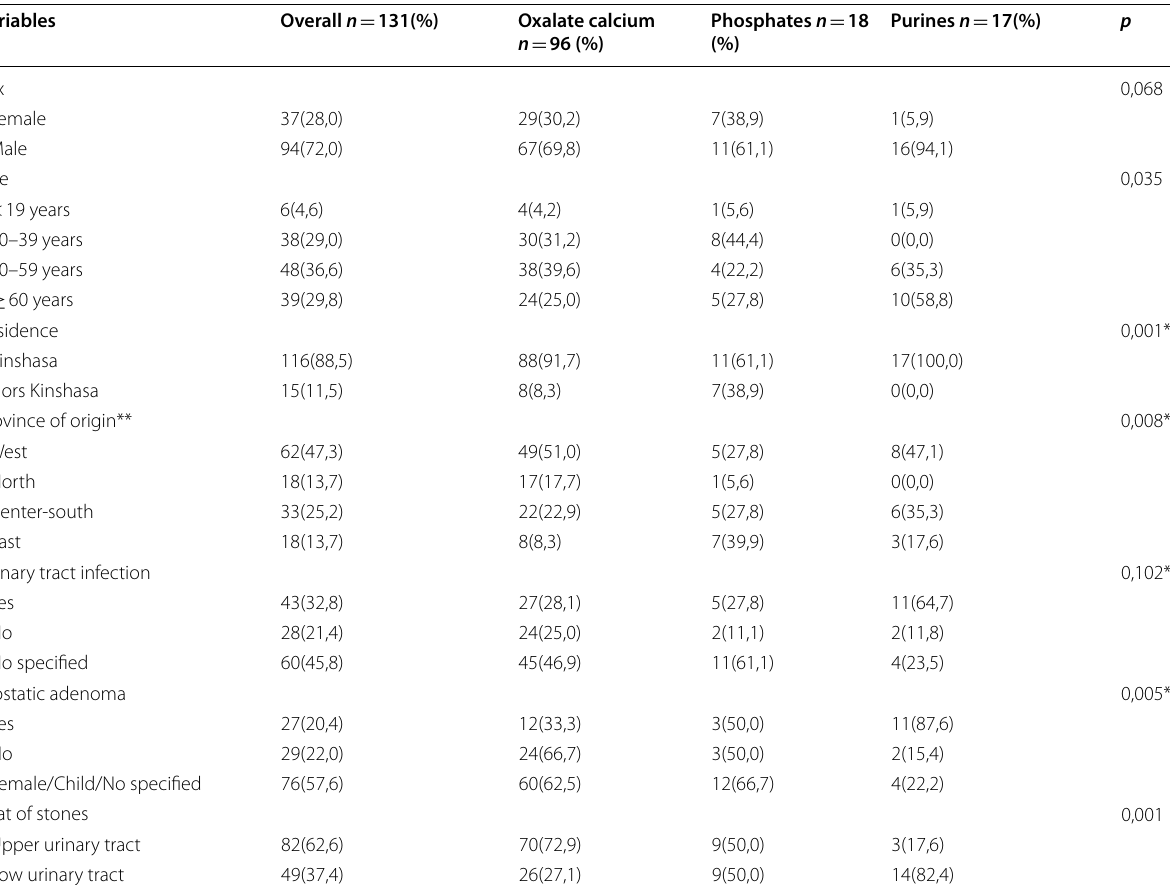
Table 7 Main types of stones grouped, socio‑demographic, and clinical profile of patients with urolithiasis